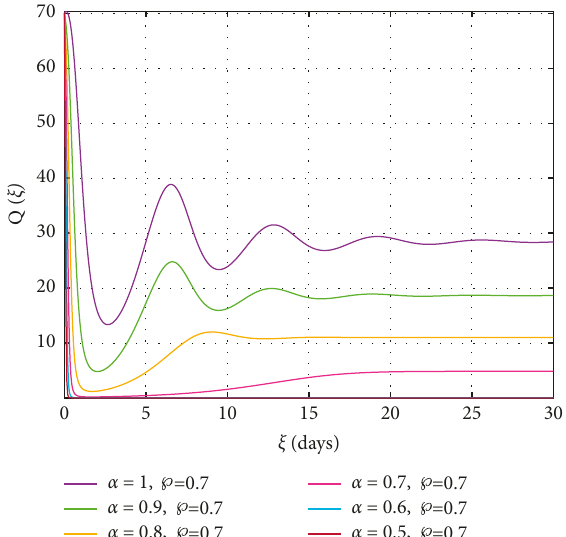
Figure 6: Displays of individuals who quit or not using Q ( ζ ) using a Newton polynomial approach for decreasing fractional-order α and fractal-dimension ℘ � 0 .